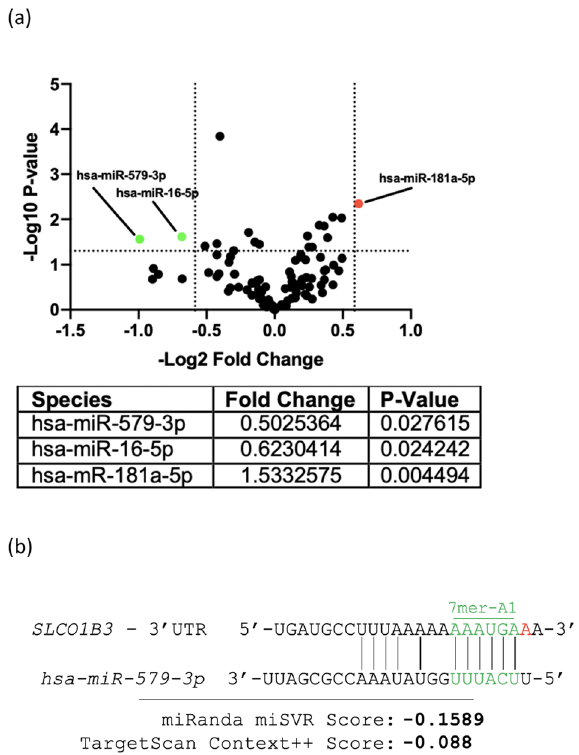
Figure 4. To investigate the relationship between miRNA and lt-SLCO1B3 expression, we profiled the miRNA transcriptome of cells treated with abiraterone using NanoString. ( a ) Differentially expressed miRNA species above 1.5-fold change and P < 0.05 in an unpaired Student’s T-test were selected for further analysis. ( b ) miRNA–mRNA binding prediction programs miRanda and TargetScan identified binding between hsa-miR-